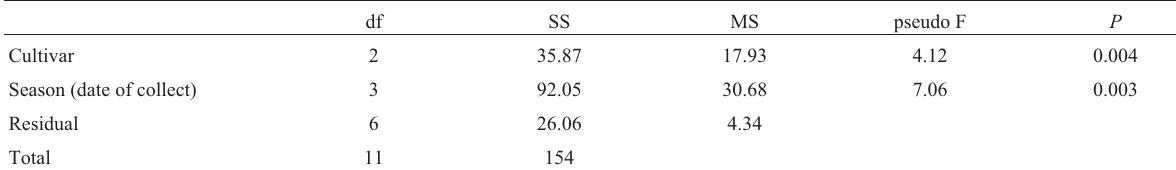
Table 4 - PERMANOVA analyses of the environmental data associated with coffee genotypes.